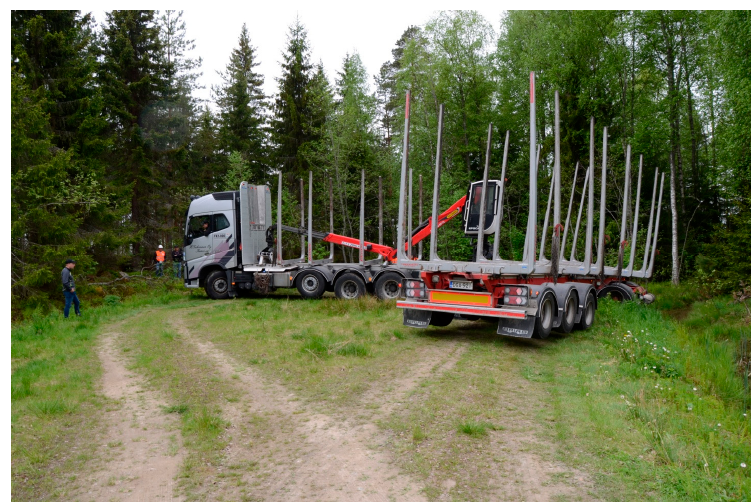
Figure 7. HCTs (76 t with crane) need larger turning places on forest roads (photo: Markus Strandström).